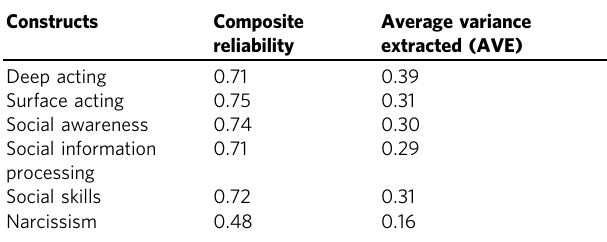
Table 5 Assessment of construct